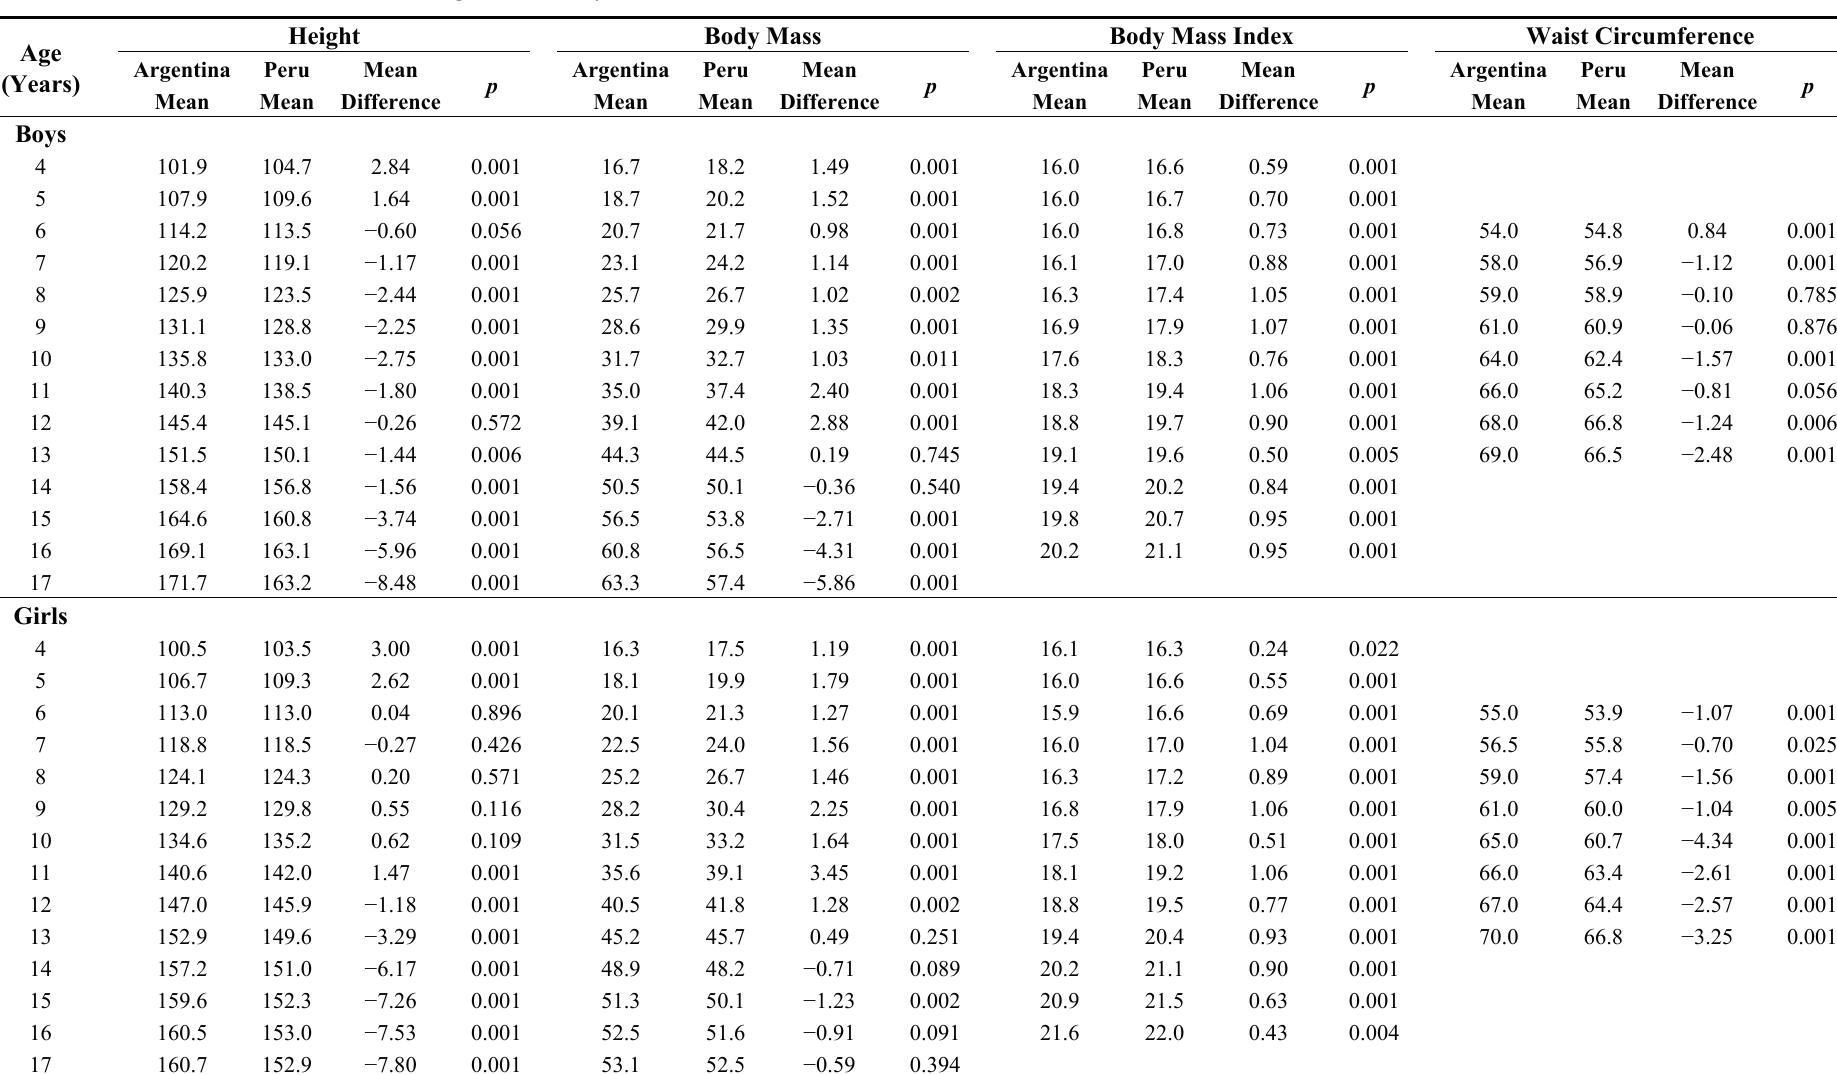
Table 7. Results of mean differences between Argentina and Peruvian schoolchildren for height, body mass, body mass index and waist circumference from both sexes aged 4 to 17